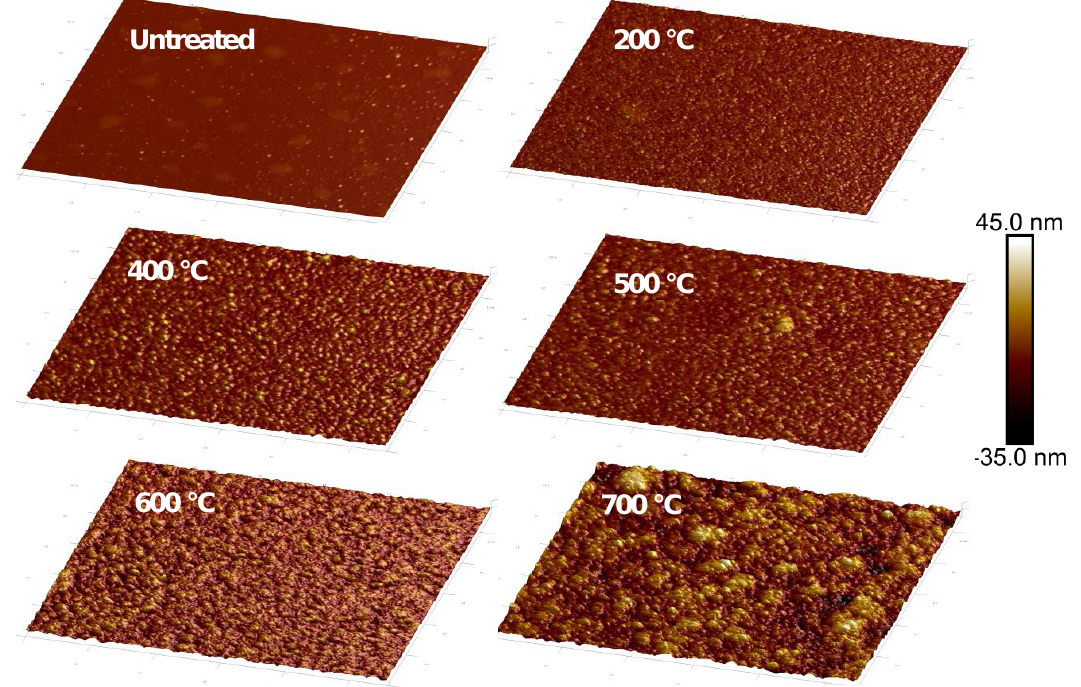
Figure 6. Three-dimensional topography plots of bare E-glass fibre: untreated and thermally conditioned at 200–700 °C.